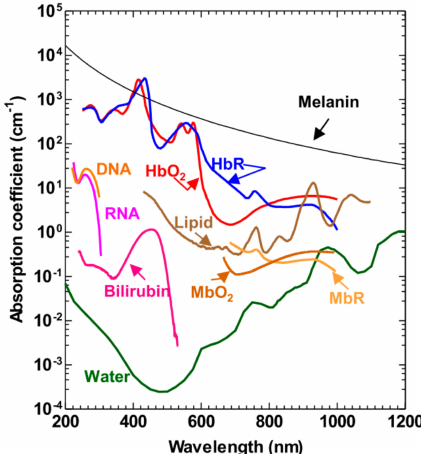
Figure 1. Absorption spectra of major endogenous contrast agents in biological tissue at normal concentrations (reproduced with permission from [16]. Copyright Elsevier,